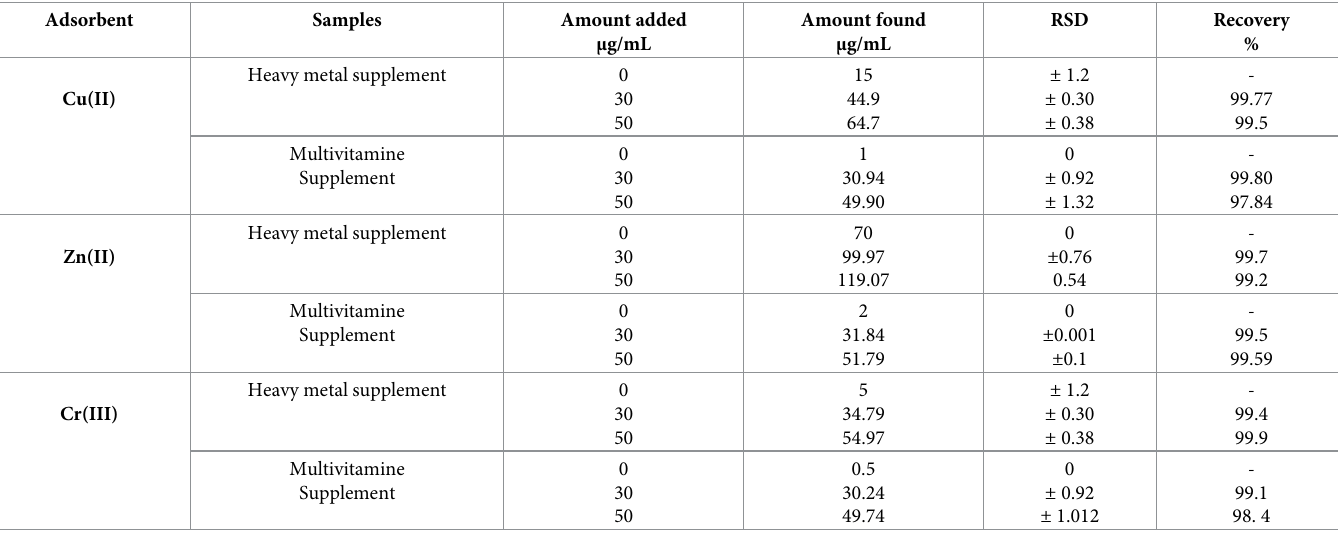
Table 7. Determination of Cu(II), Zn(II), and Cr(III) ion in two supplements. Adsorbent Samples